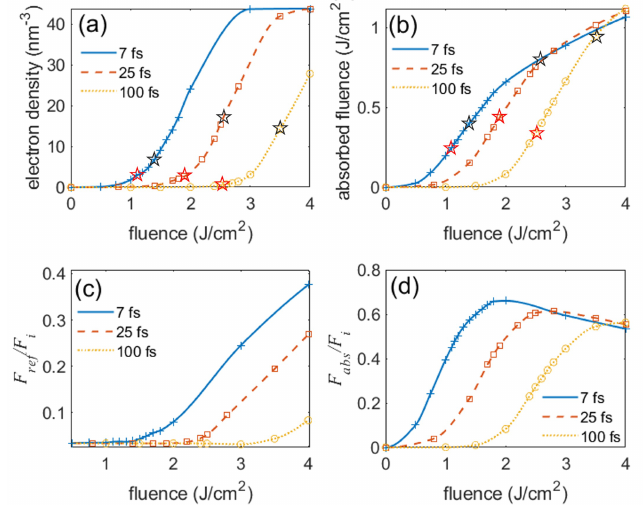
Figure 4. Simulation results for the interaction of bulk fused silica and pulses of various parameters along y = 0 (see Figure 3a). ( a ) Peak electron density; ( b ) Cumulative absorbed fluence; ( c ) Fractional reflected fluence; ( d ) Fractional absorbed fluence. The red and black stars represent the LID and ablation thresholds in [27,47], respectively. The crosses, squares, and circles represent the simulation data points for the 7 fs, 25 fs, and 100 fs pulses, respectively. The lines drawn through these points are merely to guide the